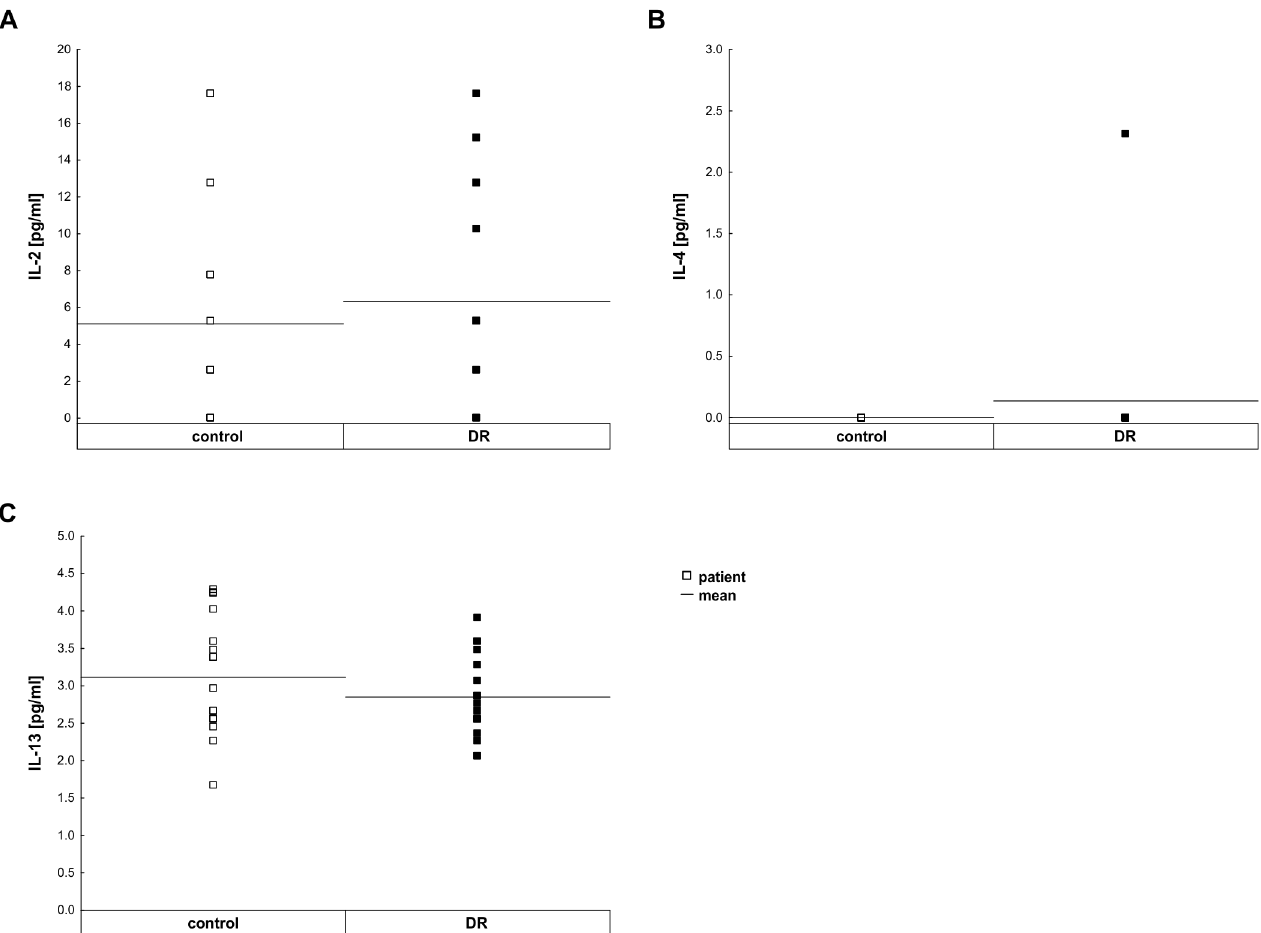
Fig 2. Contribution of pleiotropic immunomodulatory cytokine levels in vitreous samples. A. A difference in IL-2 (p = 0.62) level was not measurable between control and DR patients. B. There was no difference in IL-4 level between control and DR patients (p = 0.78). C. A trend for the down-regulation of IL-13 level (p = 0.36) was noted in DR patients. Each symbol depicts an individual patient. The horizontal bar indicates the mean cytokine concentration per group.